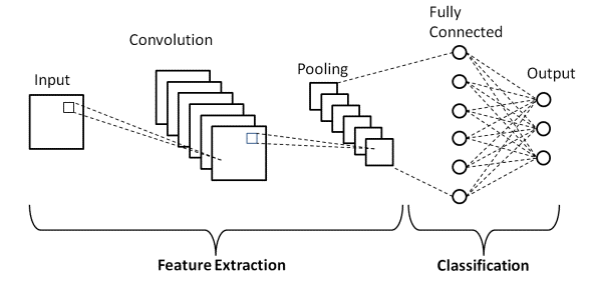
Figure 2 . Representation of the Architecture of a simple CNN